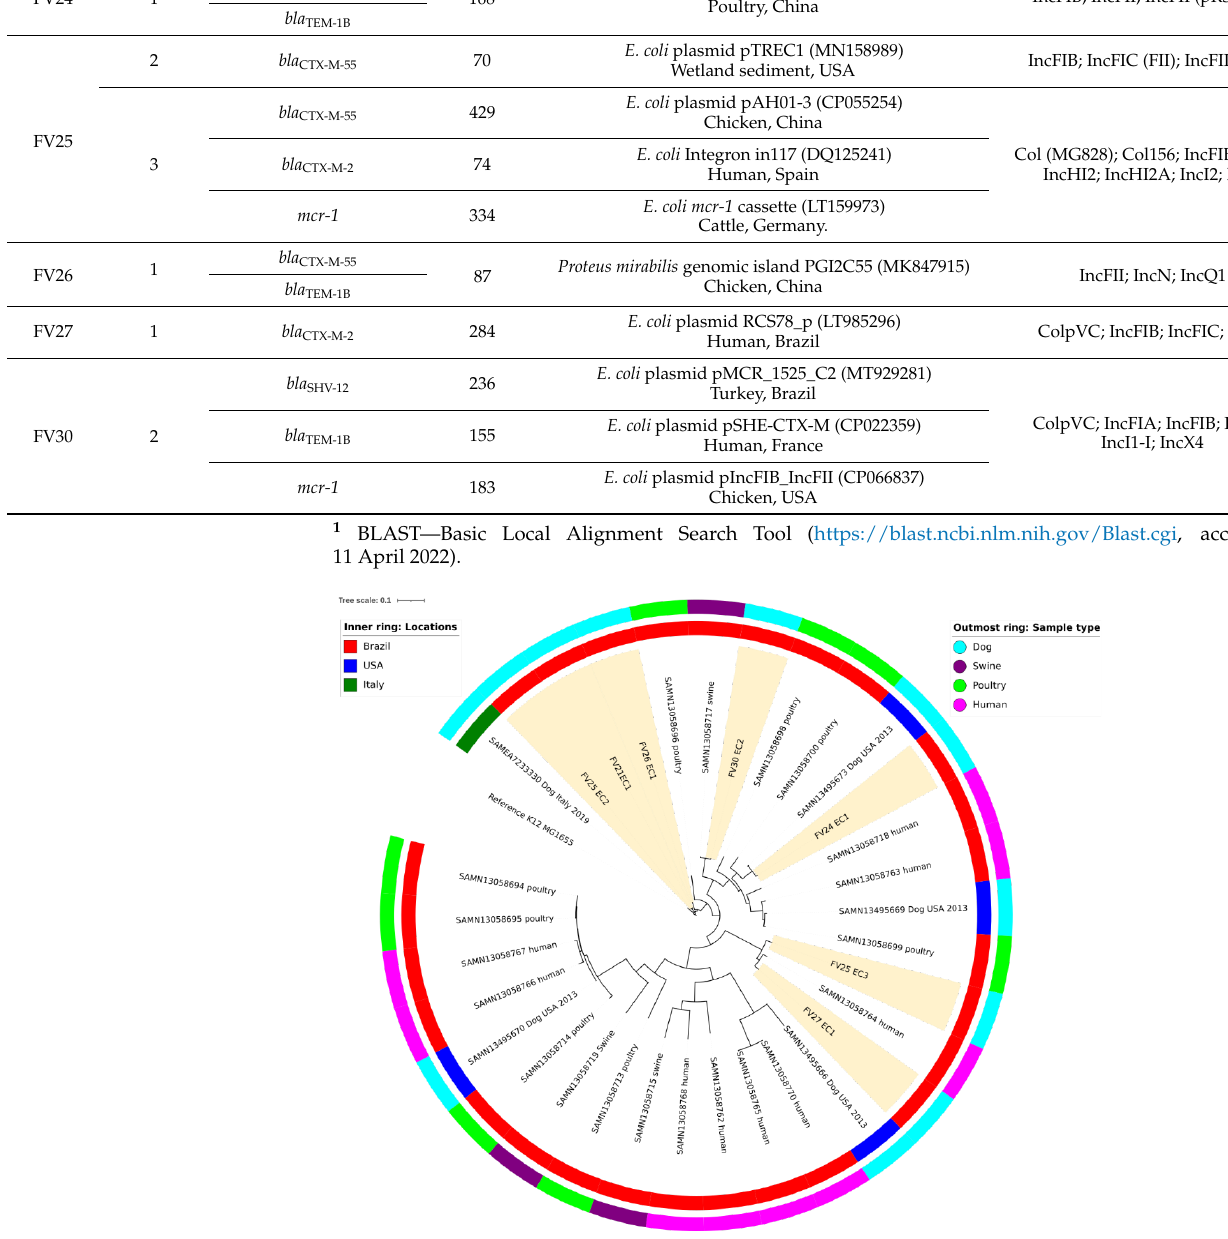
Figure 3. Phylogenetic tree of single-nucleotide polymorphisms (SNPs) found in the core and acces- sory genome from the seven E. coli isolated from dogs fed raw meat-based diets (RMBDs). Ten iso- lates from dogs, swine, poultry, and humans (outmost ring: sample type) from Brazil, Italy, and USA (inner ring: locations) were added for comparison purposes; cluster formation among RMBD- fed dogs (FV30 EC2, FV24 EC1, FV25 EC3, and FV27 EC1), swine, humans, and poultry E. coli are observed.